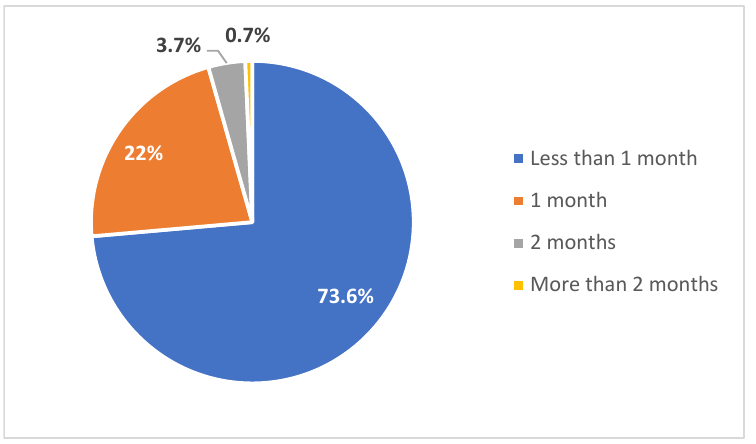
Figure 5. Food kit